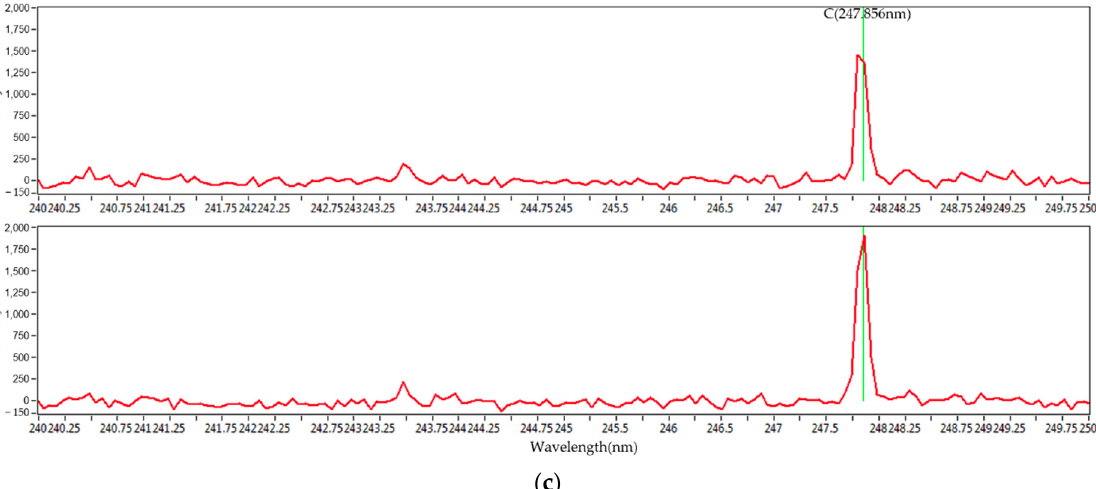
Figure 3. ( a ) LIBS spectra of mixed coal samples and carbon peaks of mixed coal samples at ( b ) 193 nm and ( c ) 247 nm.